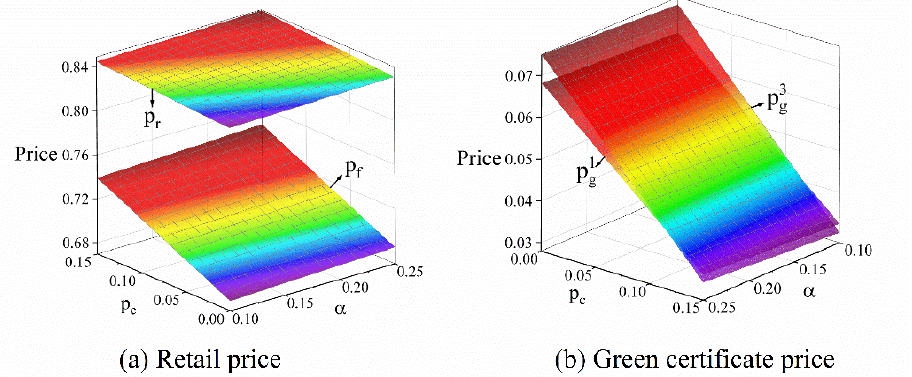
Figure 7. The trend of the price under different levels of α and p c .